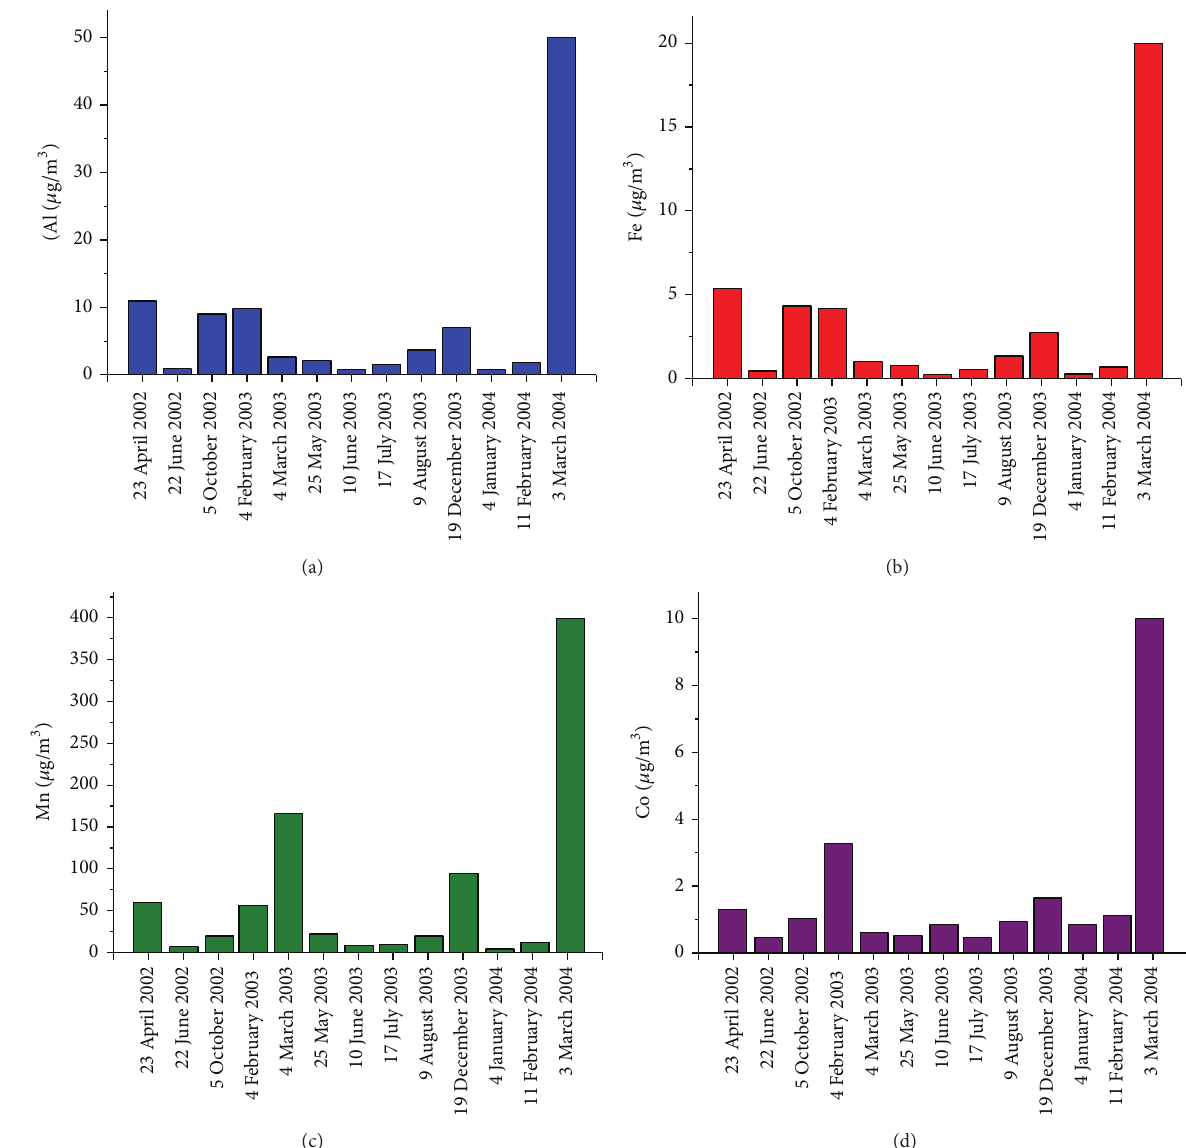
Figure 16: Dry metal deposition fluxes of (a) Al, (b) Fe, (c) Mn, and (d) Co at Gran Canaria, high dry deposition marked on 3 March 2004